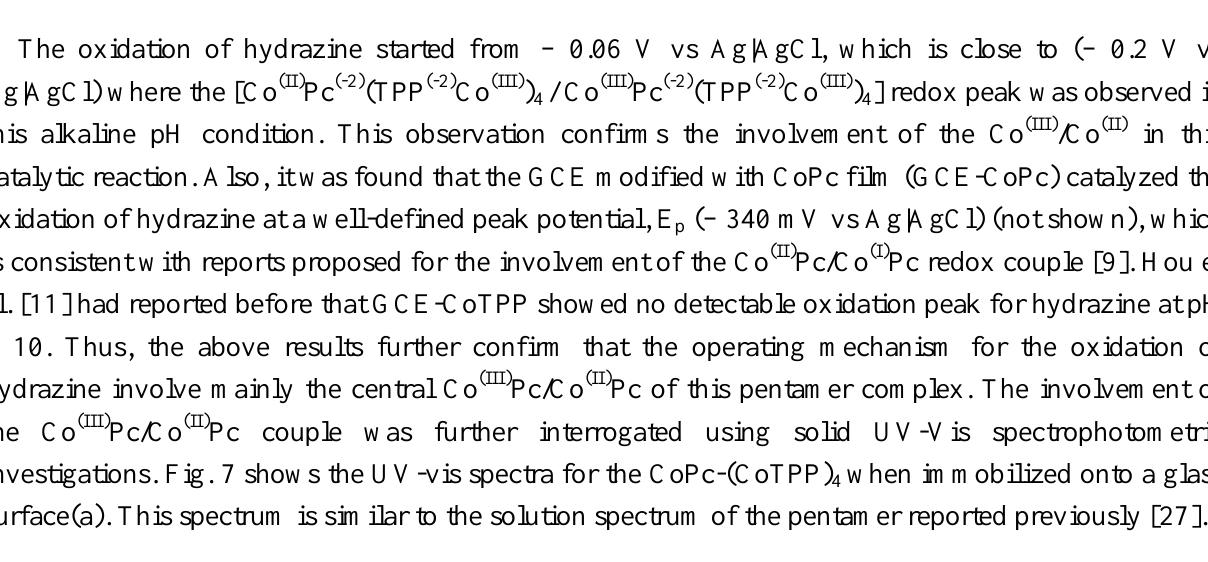
Figure 6: Typical cyclic voltammograms recorded at a GCE-CoPc-(CoTPP) without (a) and with (b) 1x10 -4 mol/L hydrazine at 25 mVs -1 . Inset shows the comparative